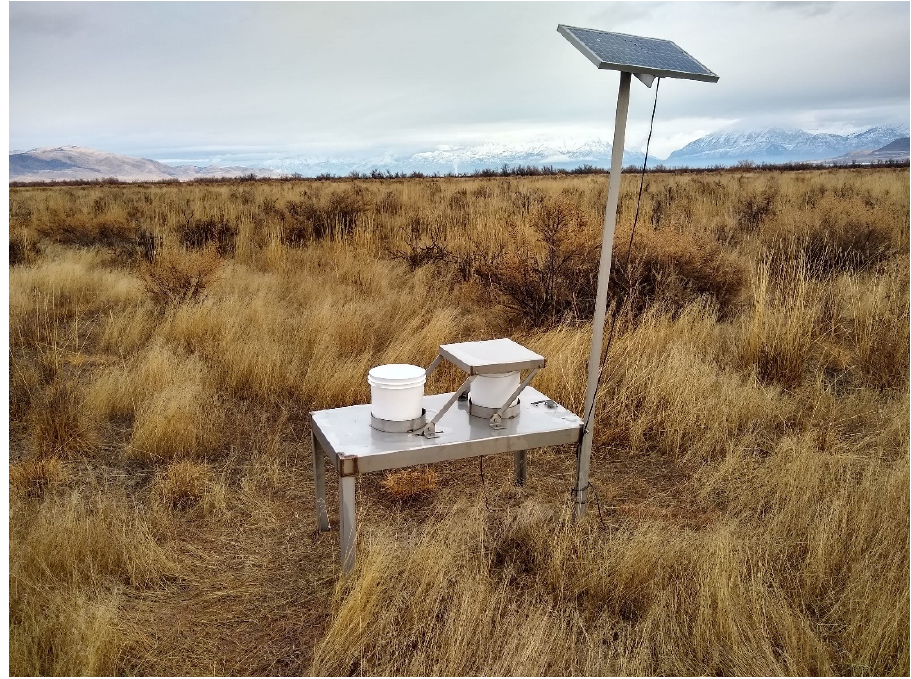
Figure 2. The sampling site at Mosida showing the early design (1916–1919) of our sampling apparatus. When rain is detected, the lid transfers to close the dry deposition sample bucket and open the wet deposition sample bucket.